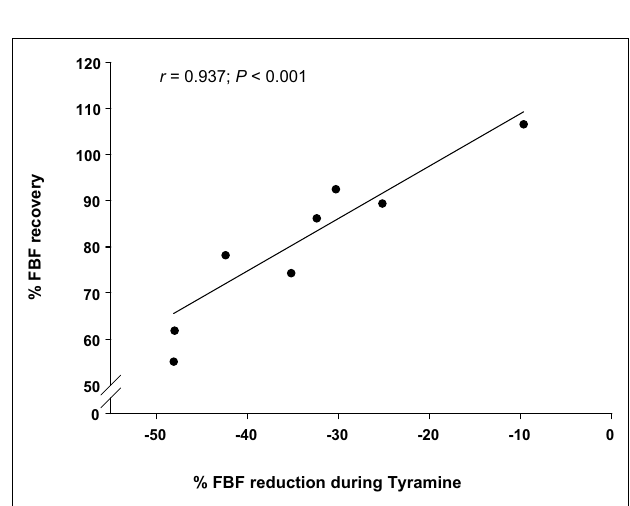
FIGURE 4 | Relationship between vasoconstrictor responsiveness and percentage recovery in forearm blood flow (FBF) during hypoperfusion. Vasoconstrictor responsiveness to endogenous norepinephrine release via tyramine (percentage reduction in forearm blood flow; FBF) is related to percentage recovery of FBF during balloon induced hypoperfusion under control (no drug)